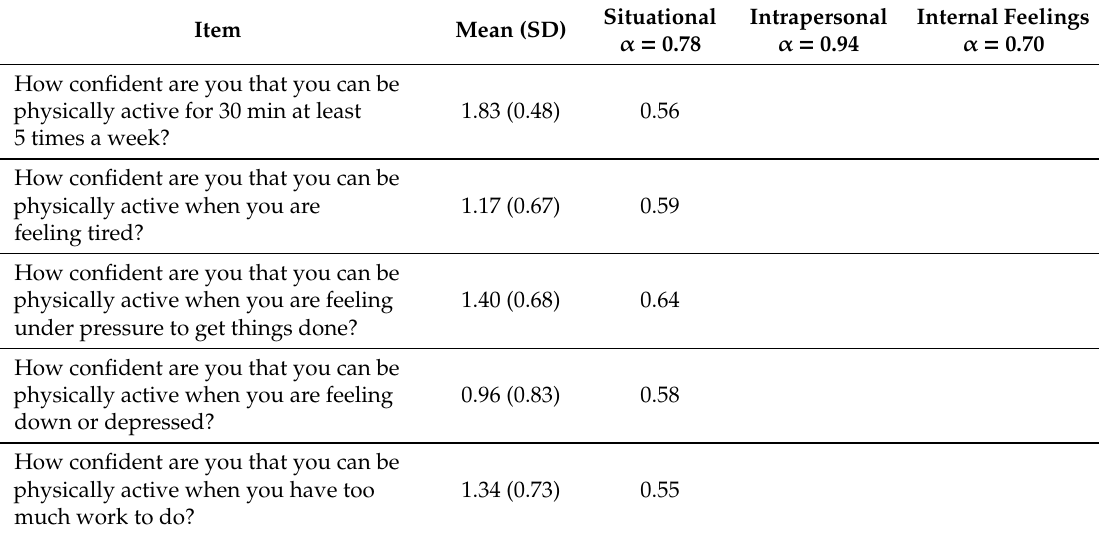
Table 1. Confirmatory factor analysis factor loadings and scale